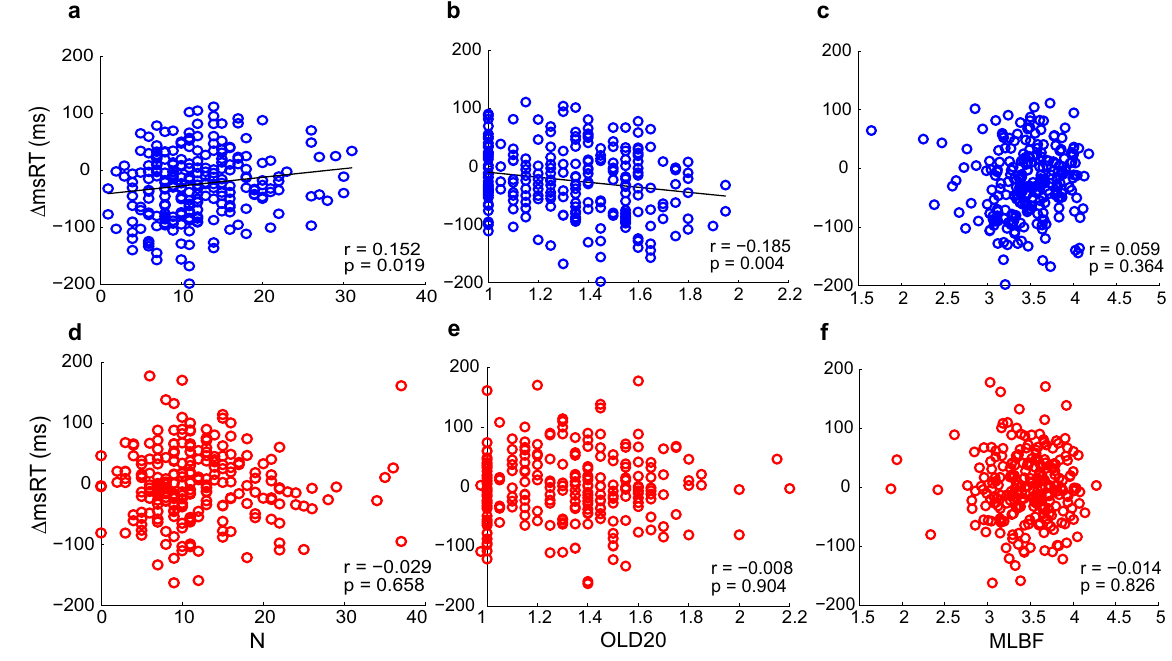
Figure 7. Correlation between word-similarity and microsaccade-timing. ( a – c ) Invented-root condition. ( d – f ) Real-root condition. In each plot, each datapoint represents the mean ∆ msRT per stimulus (N = 240 in each condition) across participants. ∆ msRT calculated for each stimulus as explained in Fig. 6, and then averaged per stimulus across participants. In the invented-root condition, significant Pearson’s correlations were found between ∆ msRT and Coltheart’s N, and between ∆ msRT and OLD20 (panels a,b, black lines represent the best linear fit of the two variables). No significant correlations were found with ∆ msRT in the Real-root condition. N = number of orthographic neighbors; OLD20 = mean orthographic Levenshtein distance to the 20 closest neighbors; MLBF = mean log bigram